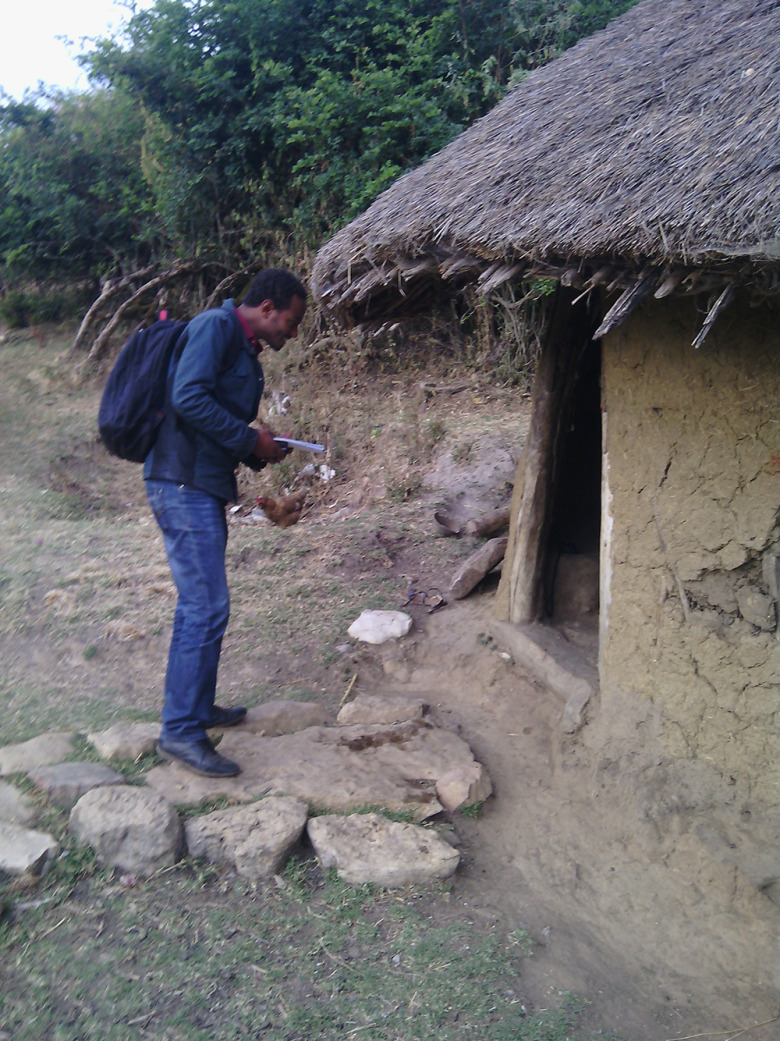
An interviewer arrives at a study participant's home to conduct household trials on antenatal calcium supplementation. © 2015 Zewdie Birhanu/Jimma University.